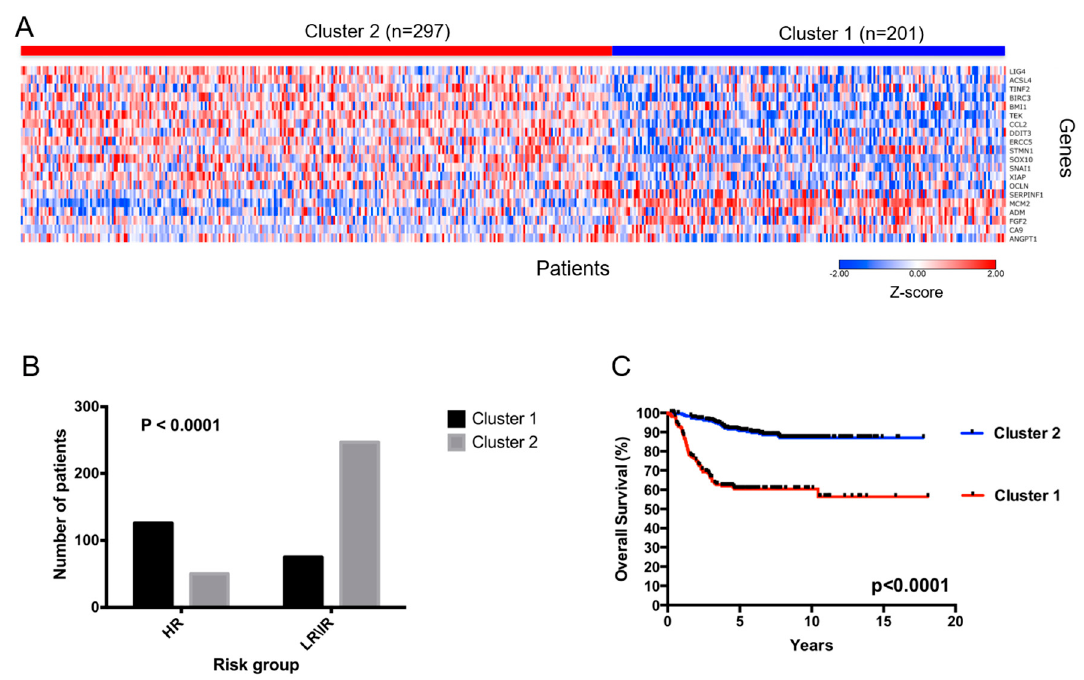
Figure 3. Progression of Tumorigenesis Genes (PTGs) and Progression of Neurogenesis Genes (PNGs) are prognostic and stratify neuroblastoma (NB) patients in two groups. ( A ) The panel shows a heat map for the 20 genes in the 498 neuroblastoma tumor dataset. The expression for each gene has been scaled using a z-score transformation and is represented by pseudo-colors in the heat map. Red color corresponds to high level of expression and blue color corresponds to low level of expression. The color key is located in the bottom right side of the plot. The 498 patients (columns) were divided into two groups by unsupervised k-means clustering. Cluster 1 consists of 201 patients and cluster 2 consists of 297 patients. The expression values of the 20 genes are shown (rows). The name of the genes is reported on the right side of the heat map. ( B ) Panel shows the number of patients of each cluster for each risk group. Risk was divided in two groups on the basis of the prognosis. The groups are high-risk vs. low- \ intermediate- risk. Association between the cluster and the risk group was assessed by Fisher exact test. Fisher p value is reported in the top left part of the plot. p value lower than 0.05 is considered significant. ( C ) Panel shows the Kaplan Meier for 498 neuroblastoma patients divided in two clusters. Curves are relative to the patient overall survival expressed in years. Blue and red curves represent good and poor prognosis patients, respectively. The p -value of the log-rank test is